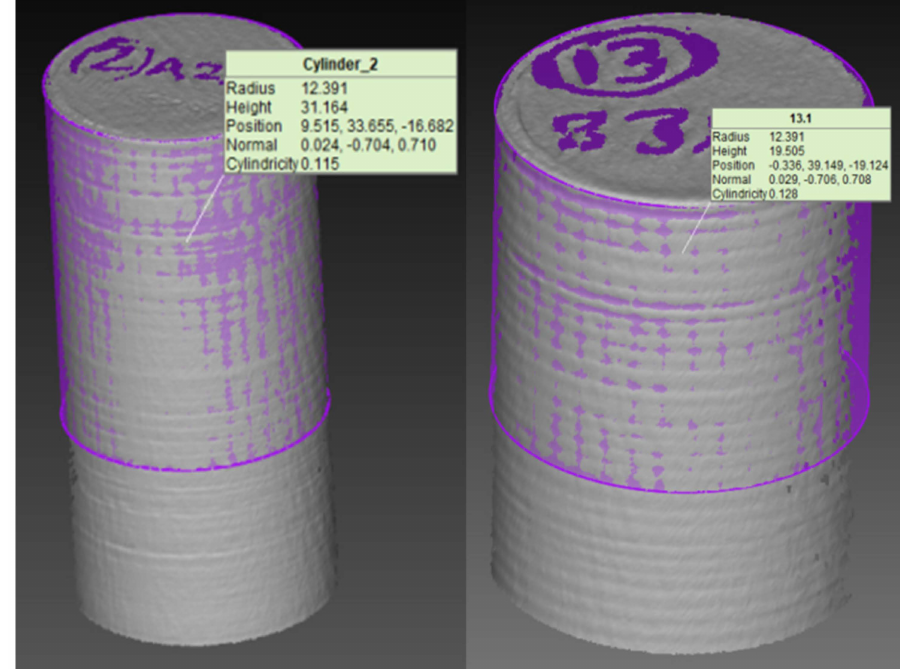
Figure 6. Cylindricity error was obtained for optimized